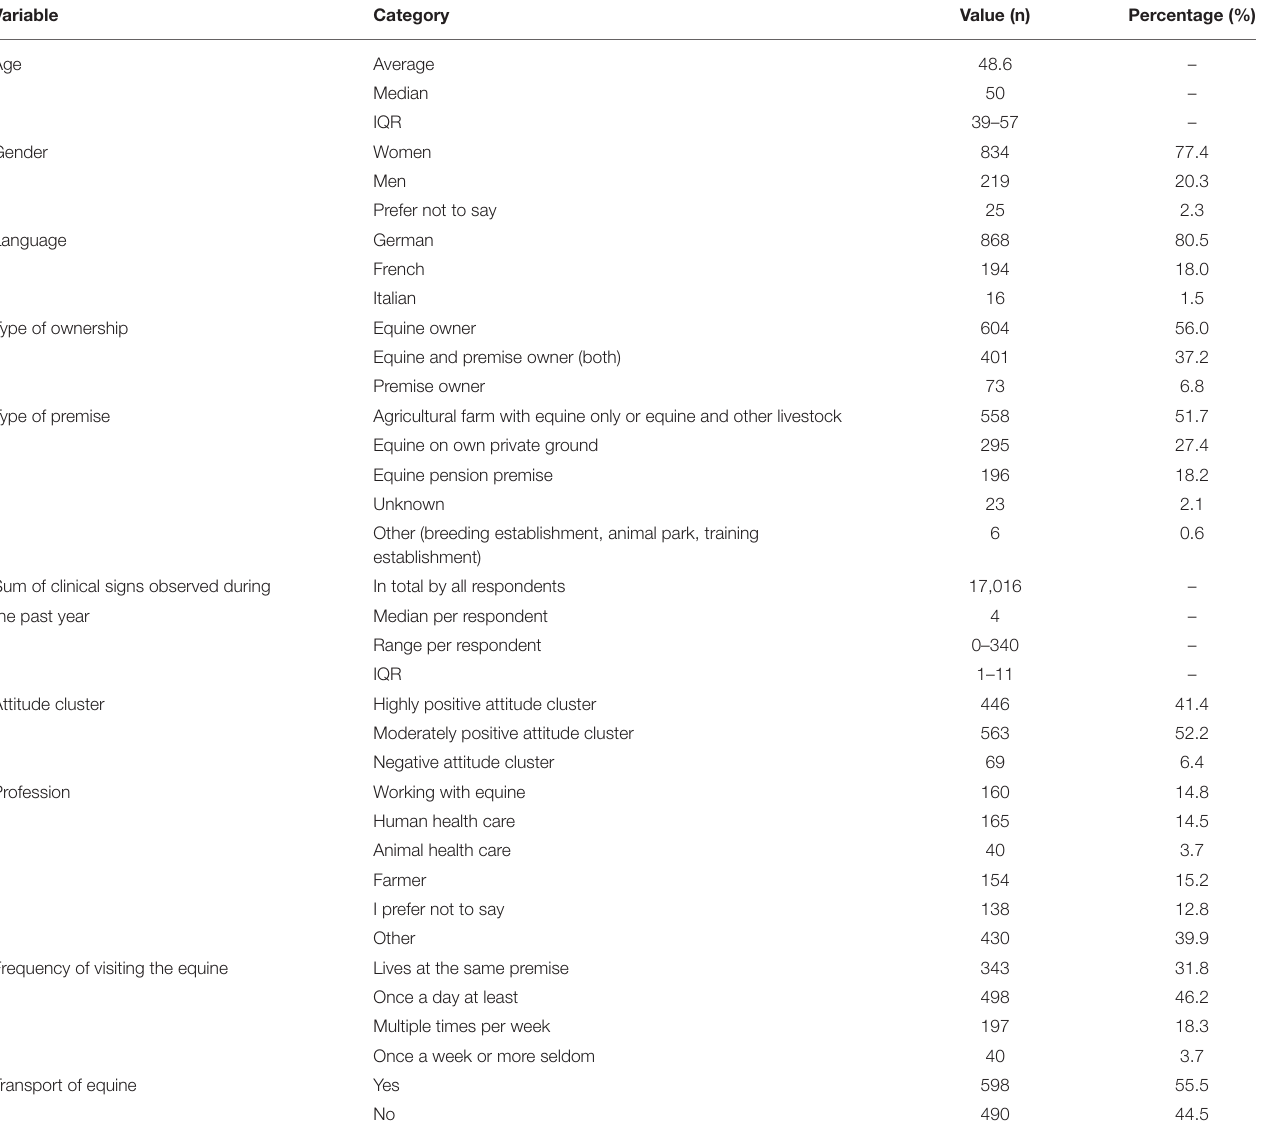
TABLE 1 | Description of the characteristics of equine owners from fully completed questionnaires, n =